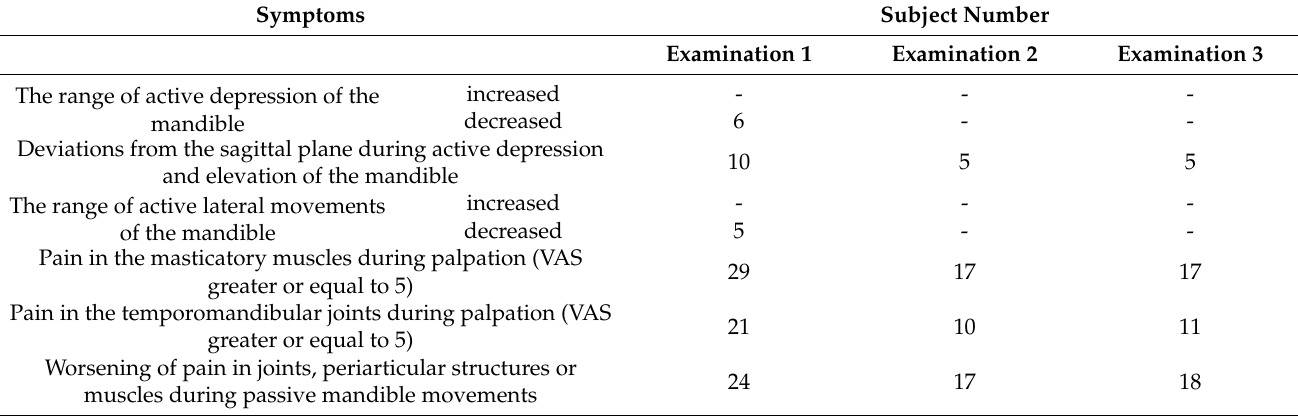
Table 2. Results of the physiotherapeutic examination of the masticatory organ obtained in group I. Symptoms